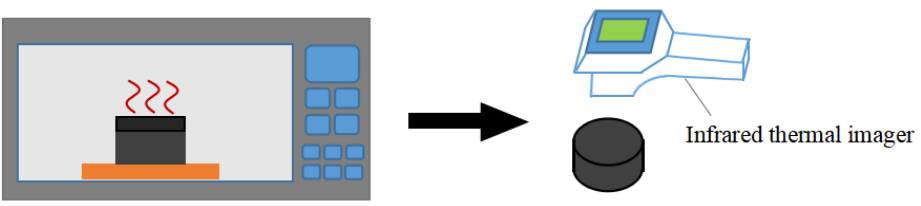
Figure 3. The process of microwave heating test.